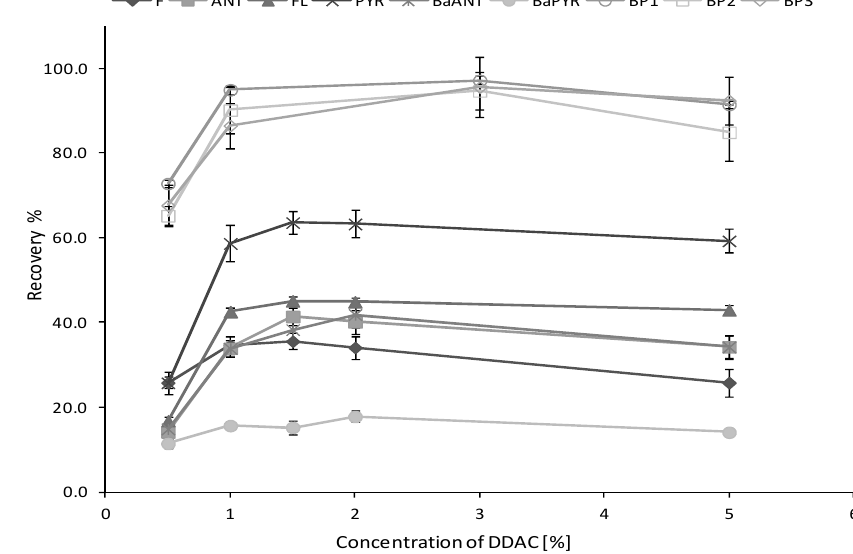
Figure 4. Impact of the DDAC concentration (%) on the recovery of the target analytes. Method